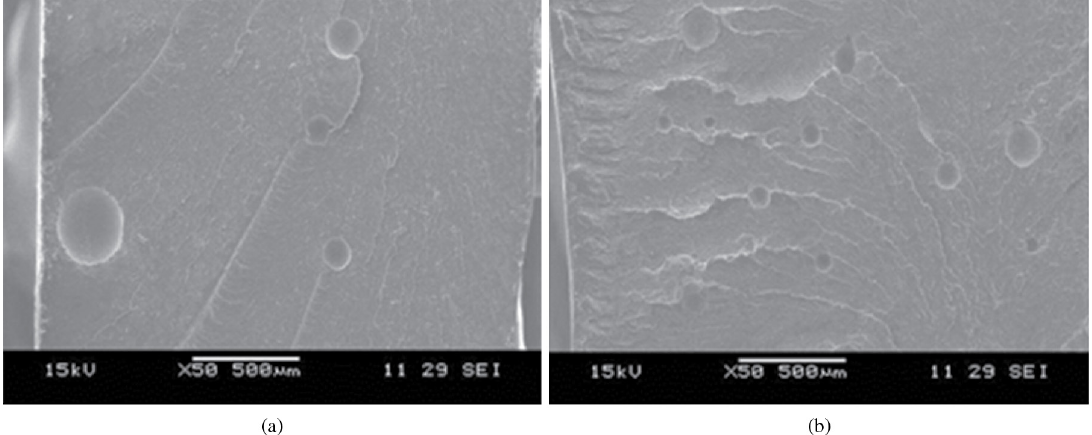
Figure 3. SEM micrographs of the cross section fractured surface of rotomolded compositeI: (a) LMDPE02 and (b) LMDPE05, with magnification of Table 6. Porosity analysis results of the rotomolded composites. Composite